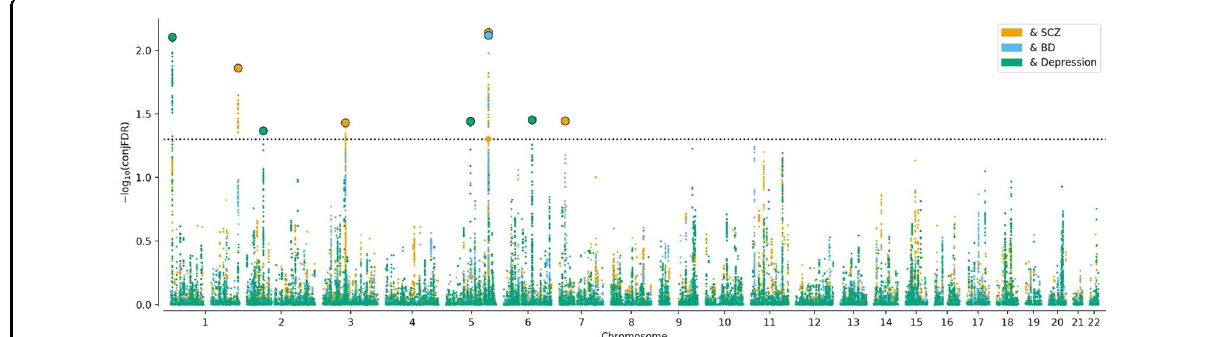
Fig. 3 Common genetic variants jointly associated with SMDs, BMI and loneliness at conjFDR <0.05. Manhattan plot showing the − log10 transformed conjFDR values for each SNP on the y axis and chromosomal positions along the x axis. SNPs with conjunction FDR < 0.05 (i.e., − log10 FDR > 1.3) are shown with enlarged data points. A black circle around the enlarged data points indicates the most signi fi cant SNP in each LD block. The fi gure shows the localization of the “ conjunctional loci ” . SMDs severe mental disorders, MD major depression, SCZ schizophrenia, BD bipolar disorder, BMI body mass index, conjFDR conjunctional